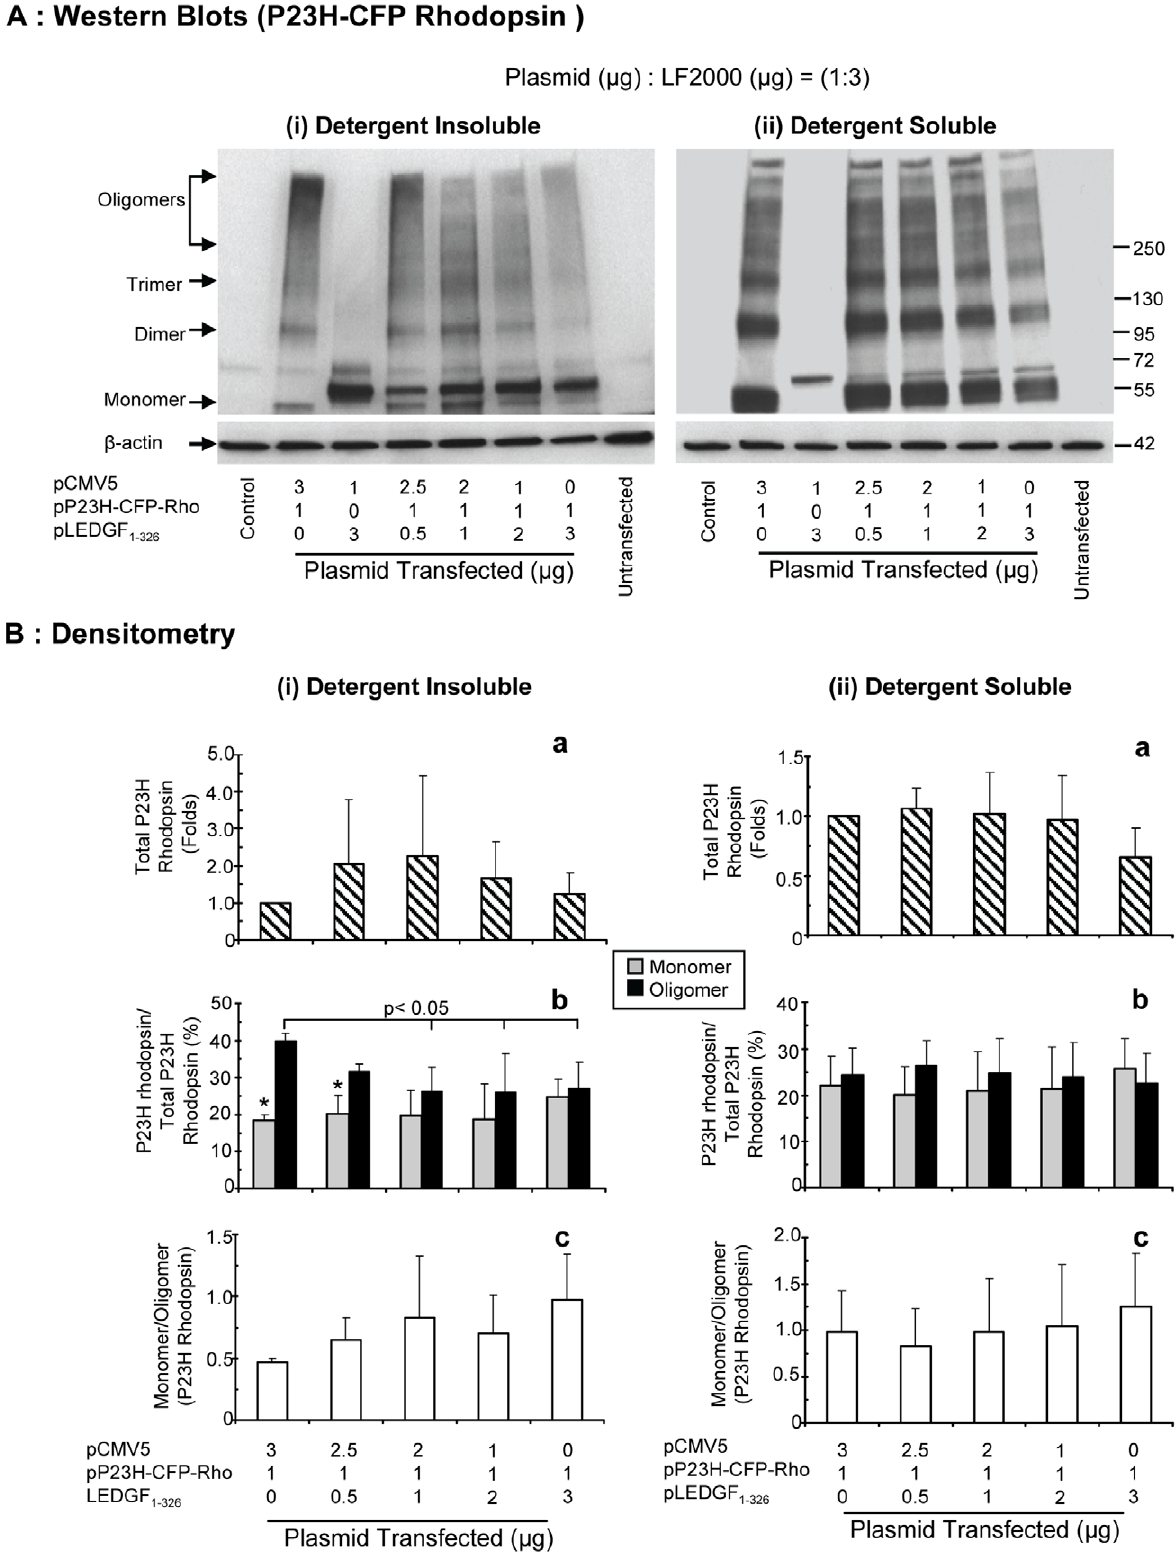
Figure 7. LEDGF 1-326 decreases the oligomers of P23H rhodopsin in RPE cells in a dose-dependent manner. A ) For western blotting cells were lysed using 1% Triton X-100 lysis buffer and the detergent soluble fraction (ii) was collected after centrifugation. Thereafter, the detergent insoluble pellet was sonicated using a probe sonicator in 1% SDS buffer, the supernatant was collected by centrifugation and described as detergent insoluble fraction (i). SDS-PAGE was run for both fractions on 4–20% gradient gel. The protein was then transferred onto nitrocellulose membrane